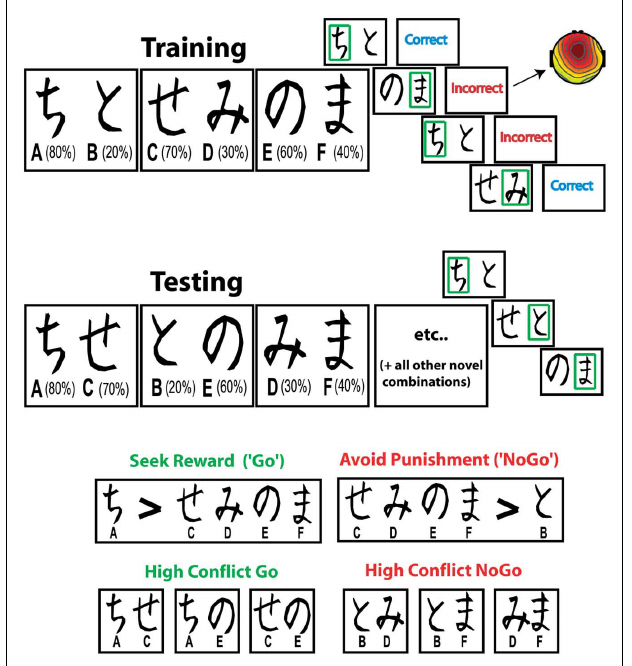
FIGURE 1 | Probabilistic learning task. During training, each pair is presented separately. Participants have to select one of the two stimuli, slowly integrating “Correct” and “Incorrect” feedback (each stimulus has a unique probabilistic chance of being correct) in order to maximize their accuracy.The FRN/theta dynamics reported here were taken following these feedbacks. During the testing phase, each stimulus is paired with all other stimuli and participants must choose the best one, without the aid of feedback. Measures of reward and punishment learning are taken from the test phase, hypothesized to reflect the operations of a slow, probabilistic integrative system during training. Note that the letter and percentage are not presented to the participant, nor are the green boxes surrounding the